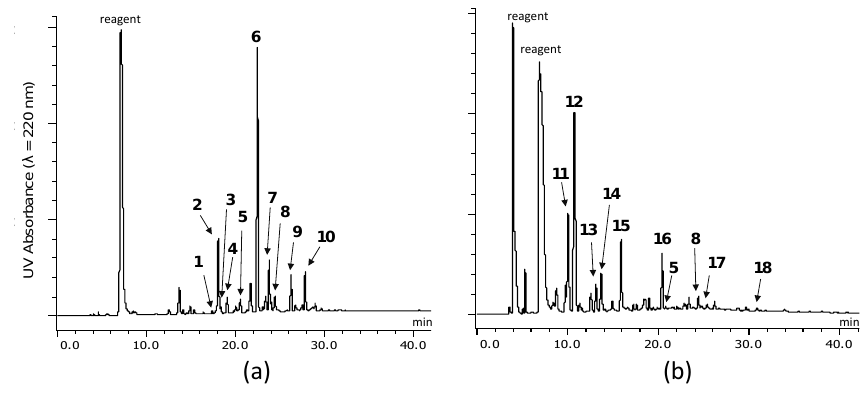
Figure 3. HPLC profiles of thiol degradation products ( a ) and phloroglucinolysis products ( b ) .